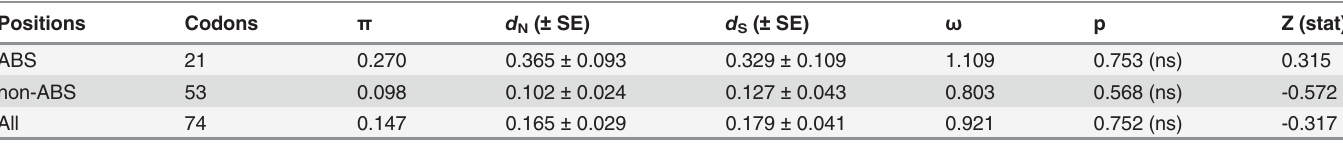
Table 1. The estimated rates of non-synonymous ( d N ) and synonymous ( d S ) substitutions for antigen-binding (ABS) and non-antigen-binding (non-ABS) amino acid positions and their ratios ( ω ).